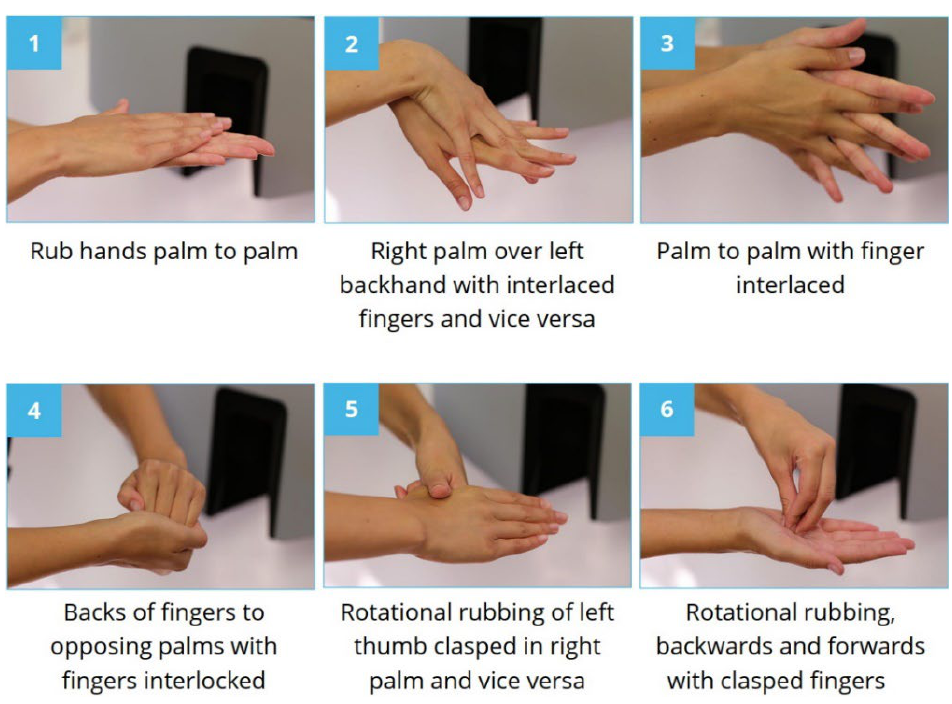
Figure 2. The correct WHO 6- step hand disinfection technique. (Source: HandInScan Zrt.) .